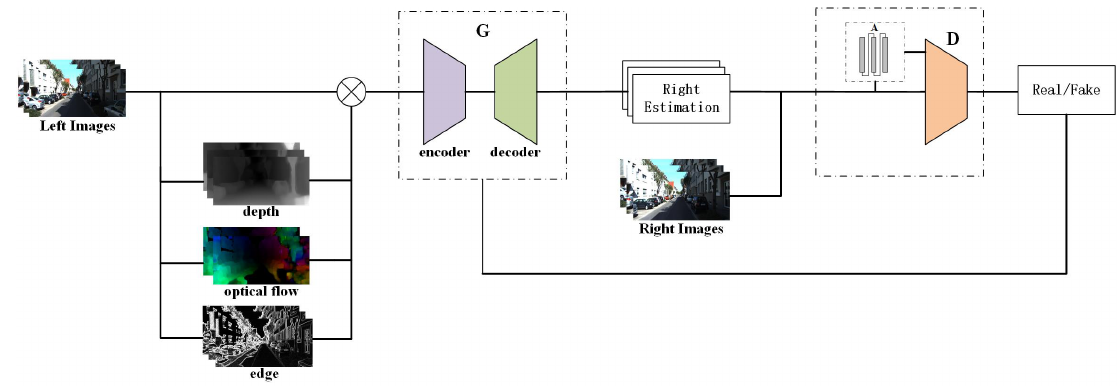
Figure 4. 3DDA-GAN networks composed by three sub-networks. G is generative network, D is discriminator network, A is attentive